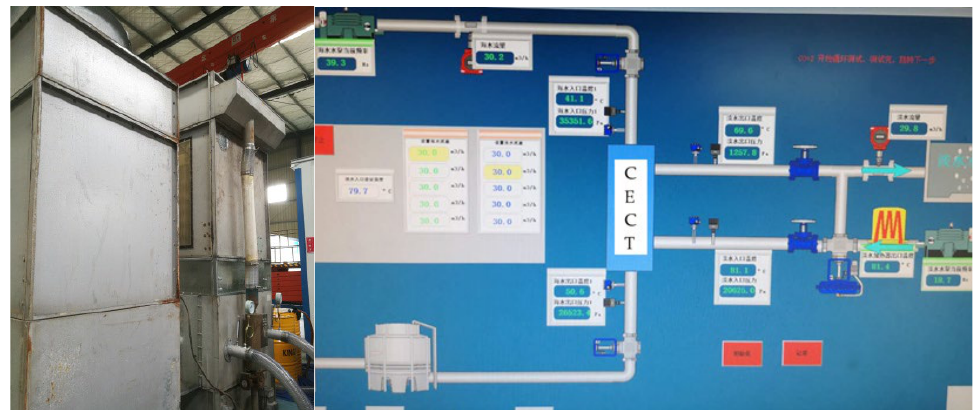
Figure 4. Experimental system control platform and experimental site.